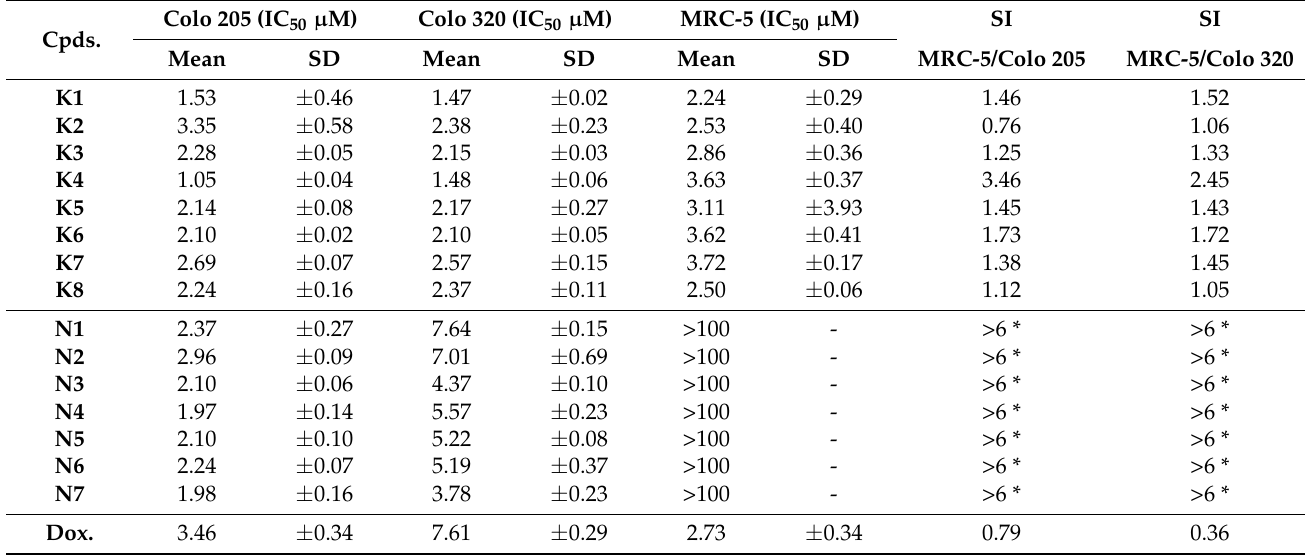
Table 3. Cytotoxic effect of selenocompounds on sensitive (Colo 205) and resistant (Colo 320) colon adenocarcinoma, and MRC-5 normal embryonal fibroblast cell lines and selectivity indexes (SI). Doxorubicin was used as a positive control. Cpds.